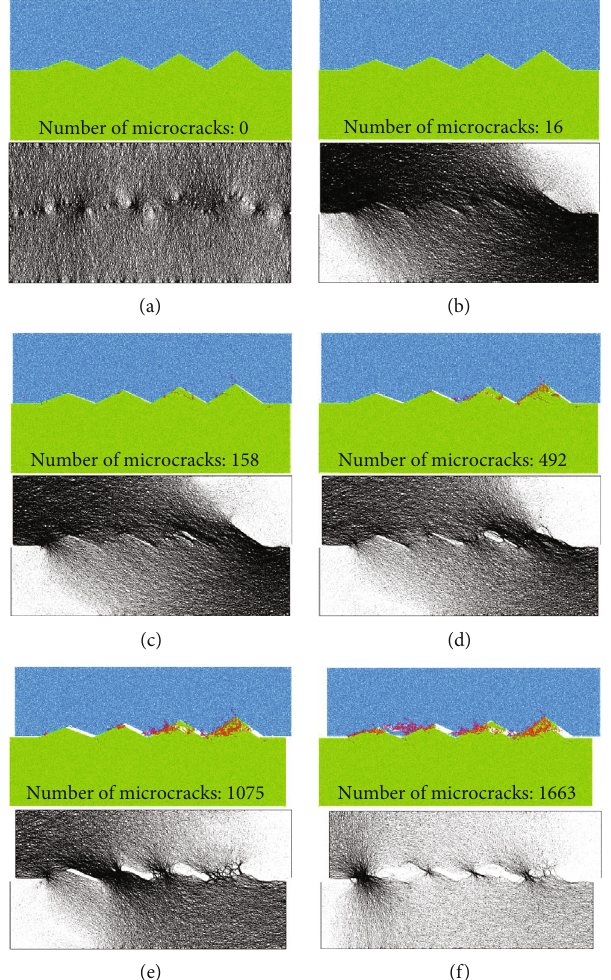
Figure 13: Contrast diagram of microcrack propagation and contact force distribution of joint sample during shear process: (a) 0mm; (b) 0.5mm; (c) 0.75mm; (d) 1 mm; (e) 2mm; (f) 3